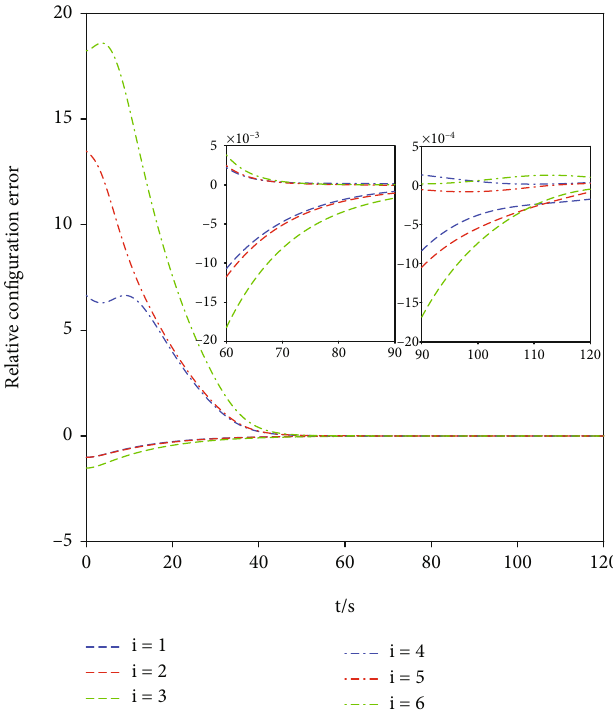
Figure 4: Relative con fi guration error curves.